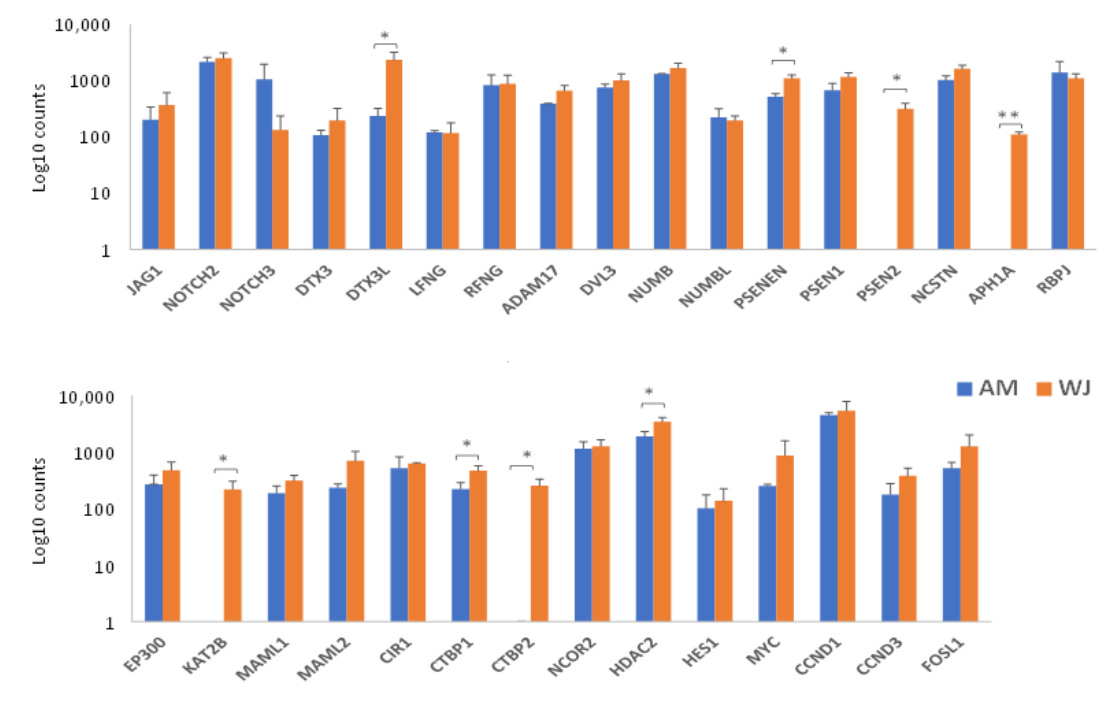
Figure 2. Notch signalling pathway-related gene expression in AM- and WJ-MSCs under basal condition. Data represented mean counts ± SD. Asterisks (*) and (**) represent statistical significance of p < 0.05 and p < 0.005, respectively.